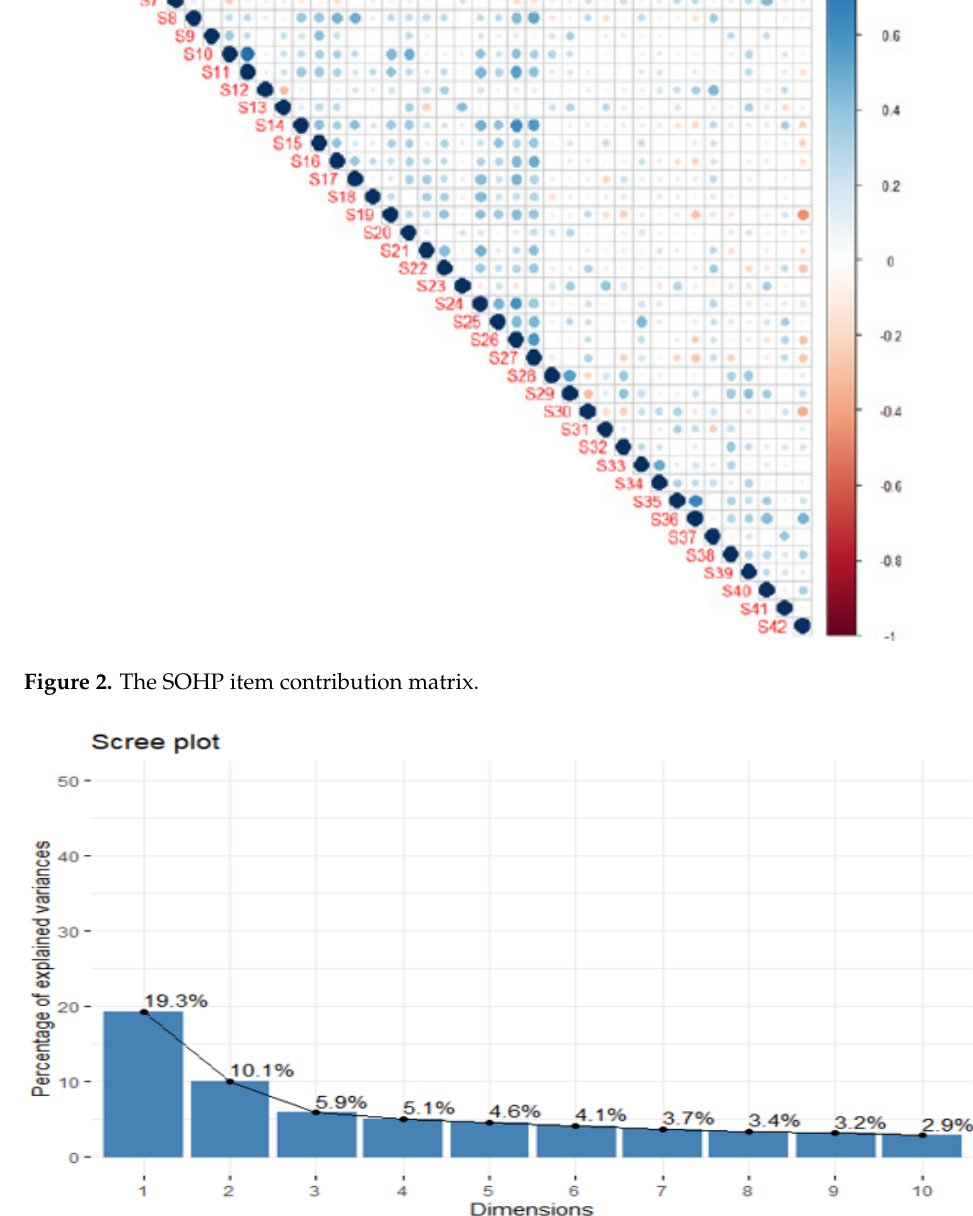
Figure 3. SOHP (42 items) eigenvalues graph.